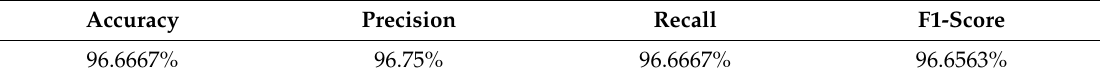
Table 2. The performance of the proposed approach on the Handicraft-Gesture dataset.